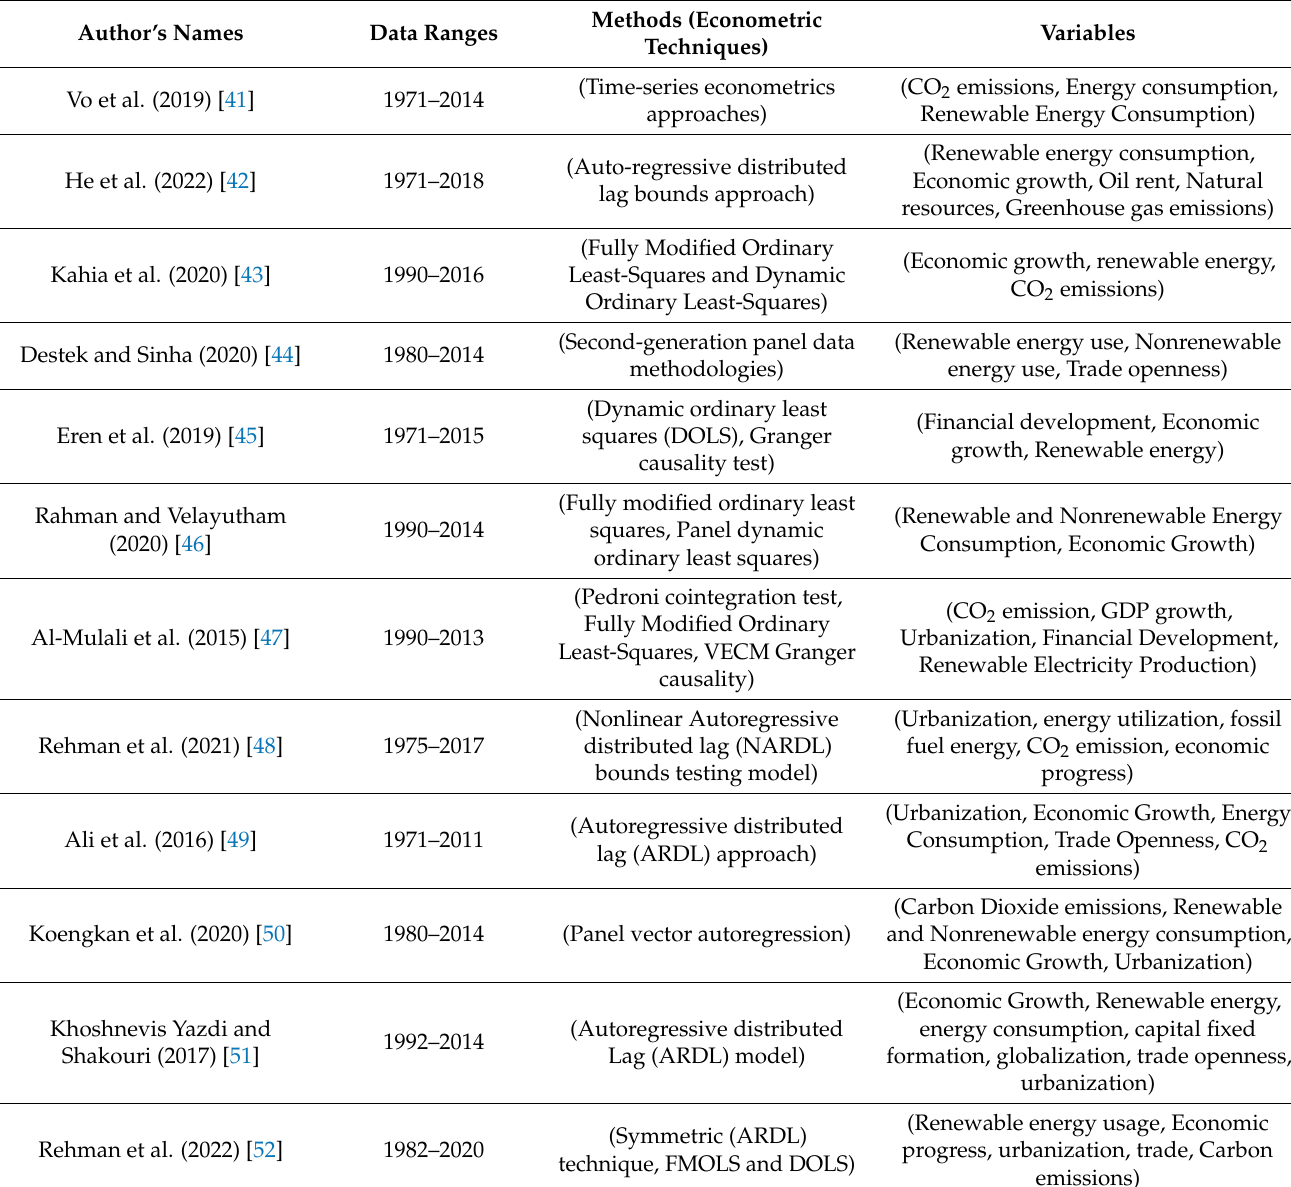
Table 1. Previous studies demonstrating the linkages among various